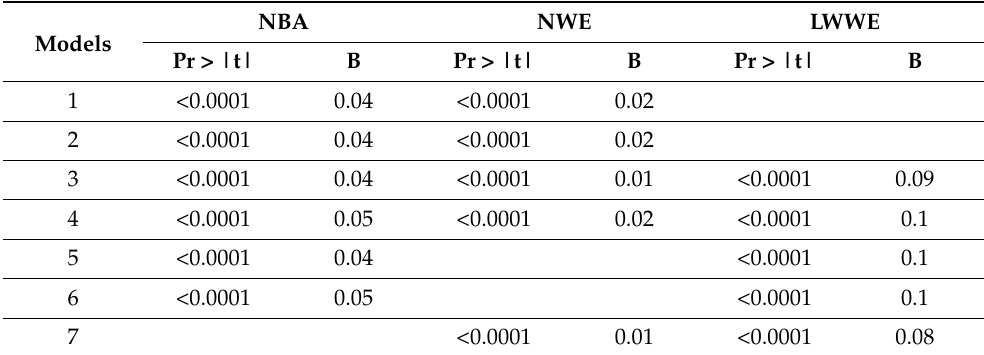
Table 6. Estimated trends for Large White.